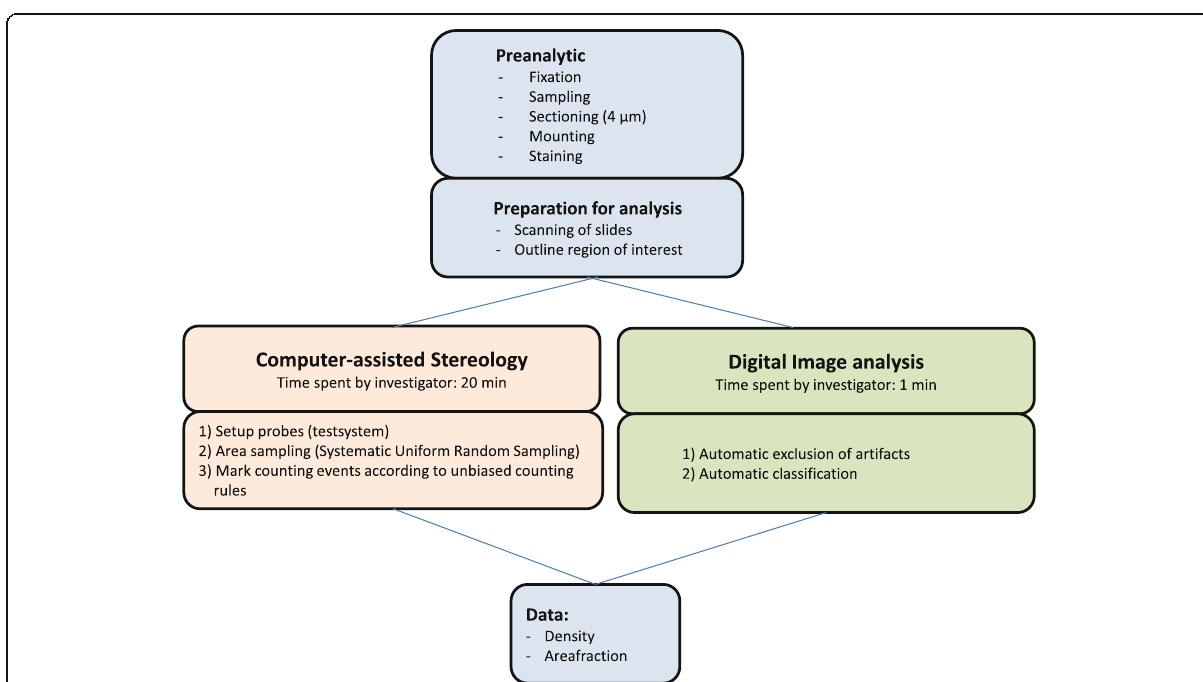
Fig. 2 Workflow for stereology and image analysis. The regions of interest were outlined manually and the exact same areas were used for both technical approaches. The stereological analysis was performed, using a computer assisted software. The field of views were selected by the software by systematic random sampling, while the counting was carried out manually by the observer. The image analysis was performed automatic using, an image analysis algoritm